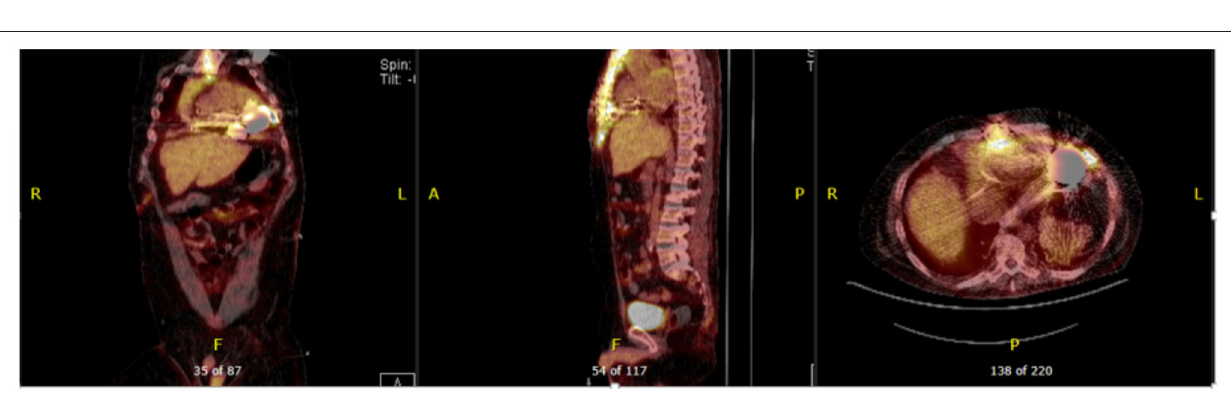
FIGURE 5 | Thirty eight year-old female with end-stage heart failure s/p LVAD (Heart Mate 3) presented with drainage around driveline exit site and abdominal pain. She was treated with oral antibiotics for several weeks but continued to have symptoms. 18 F-FDG PET-CT was obtained to assess extent of infection and showed increase FDG uptake surrounding LVAD driveline in the anterior abdominal wall without collections. She underwent driveline debridement for DLI and the driveline exit was relocated medially.